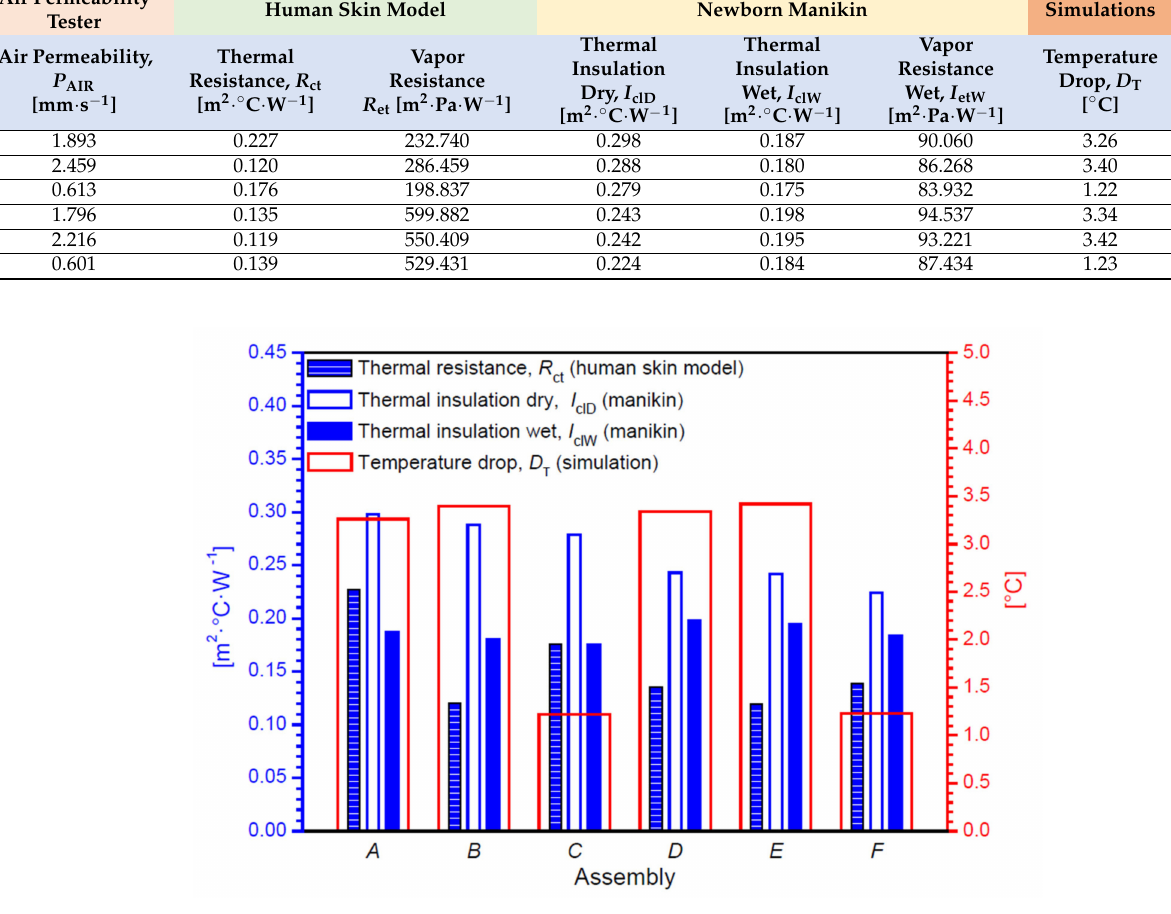
Figure 10. Measured and simulated biophysical properties of tested